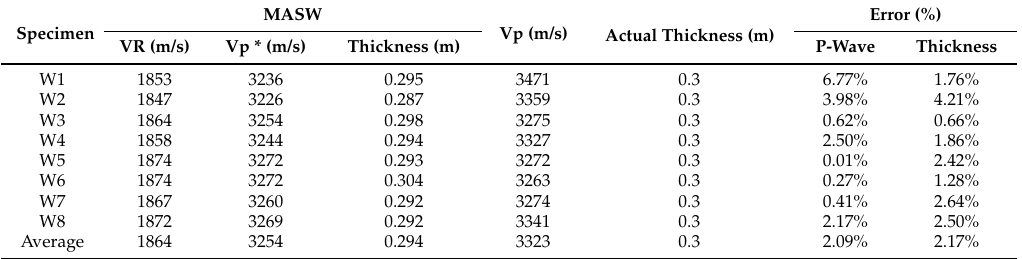
Table 3. Comparison of MASW results with the measured P-wave velocities and the actual thickness. MASW Specimen